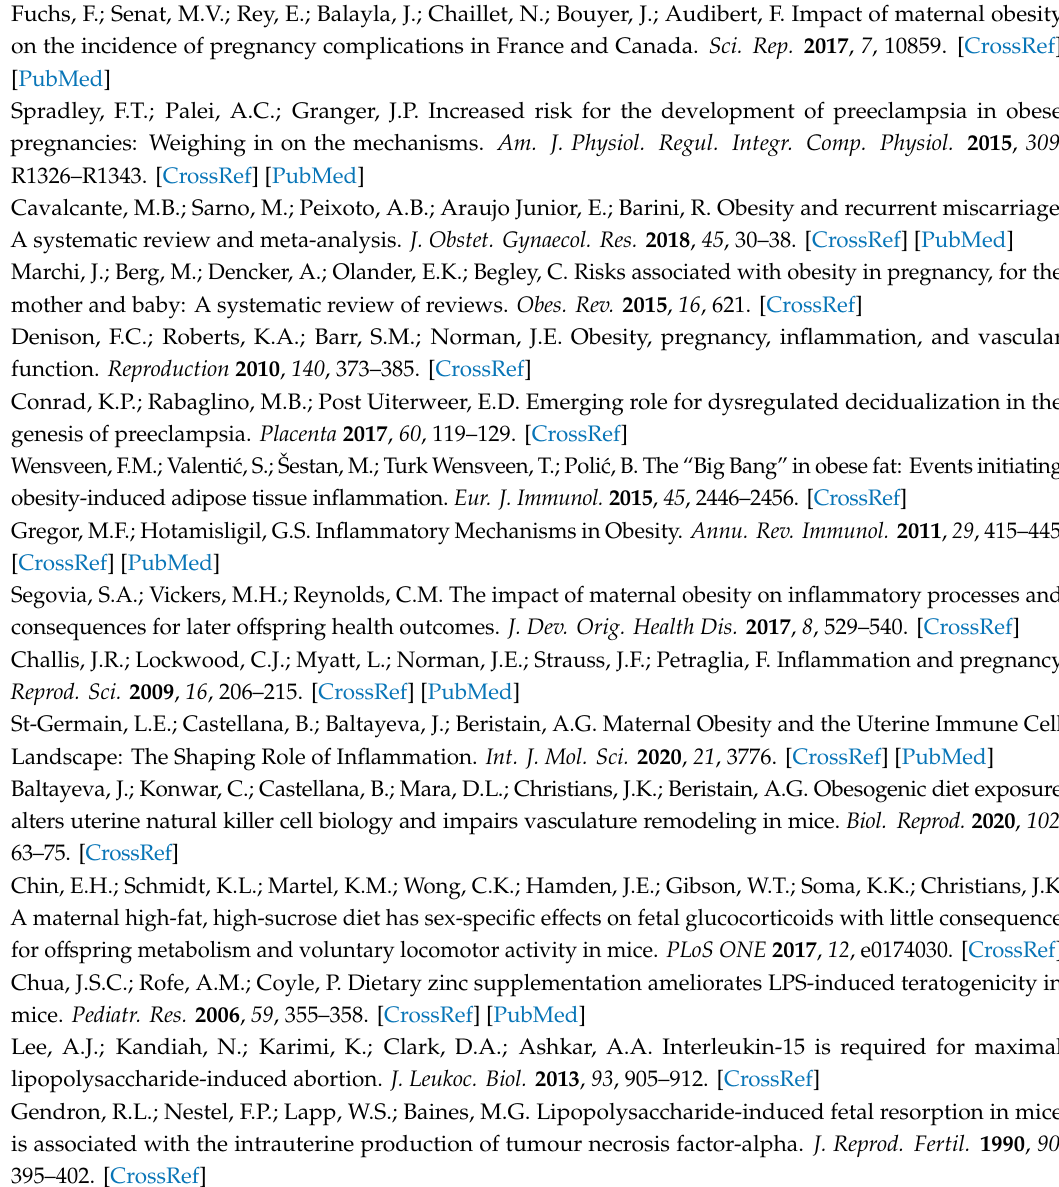
Table S1: Raw data used in analyses; File S1: SAS code used for